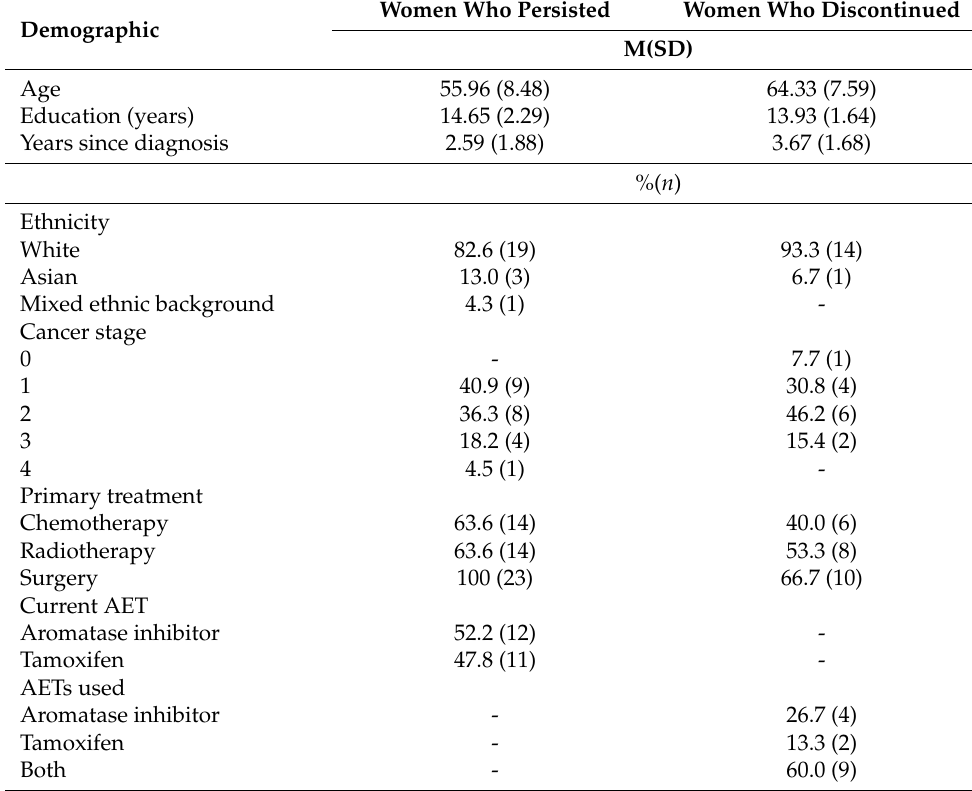
Table 1. Demographic information for women who persisted ( n = 23) and discontinued ( n =